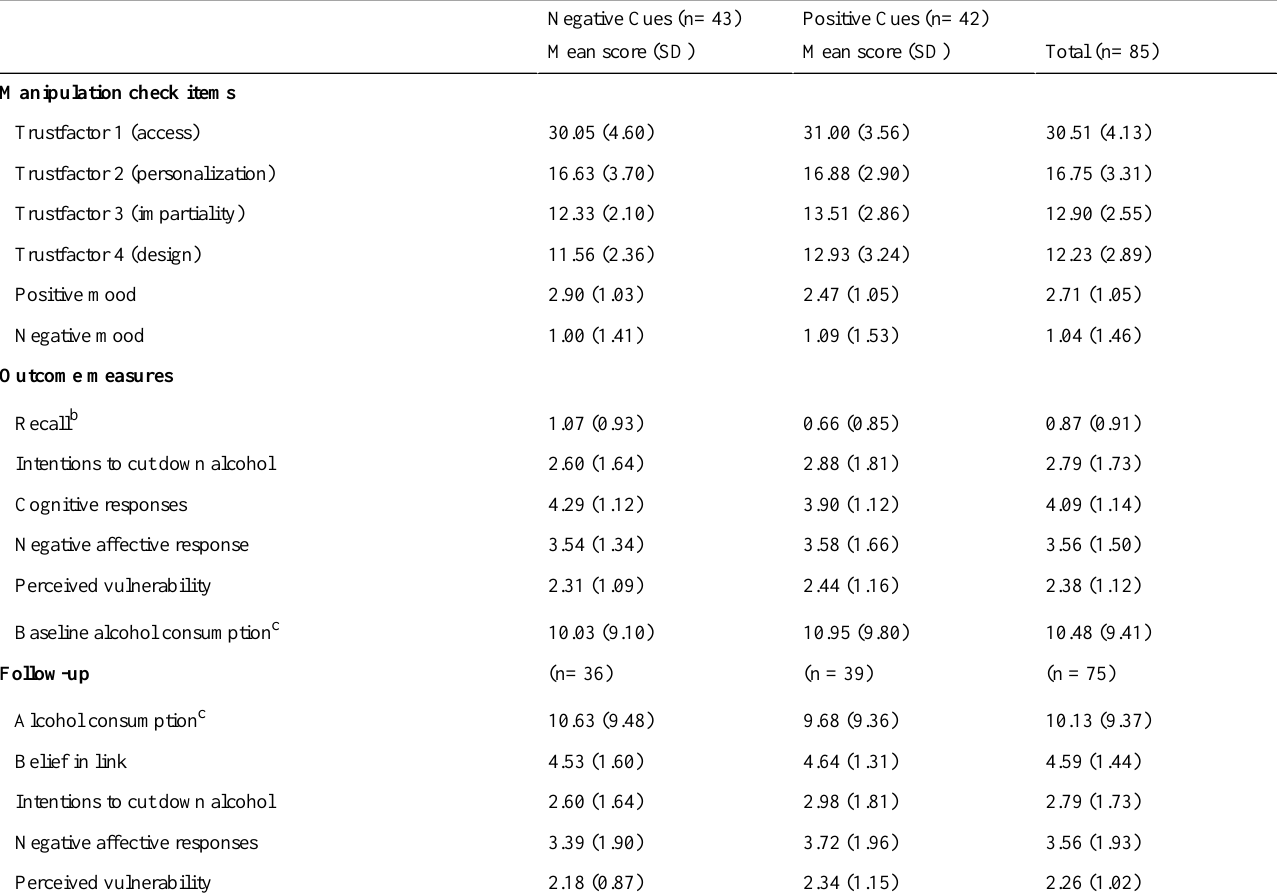
Table 3. Other dependent variables, by condition